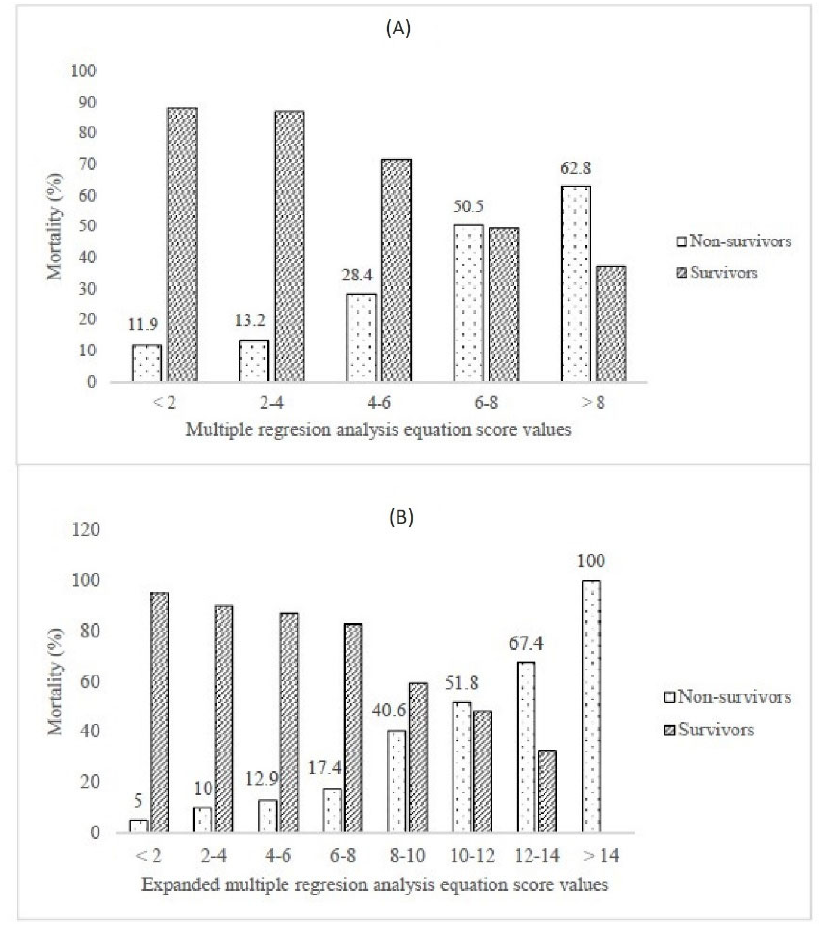
Figure 2. Mortality according to ( A ) multiple regression analysis and ( B ) expanded multiple regres- sion analysis equations .